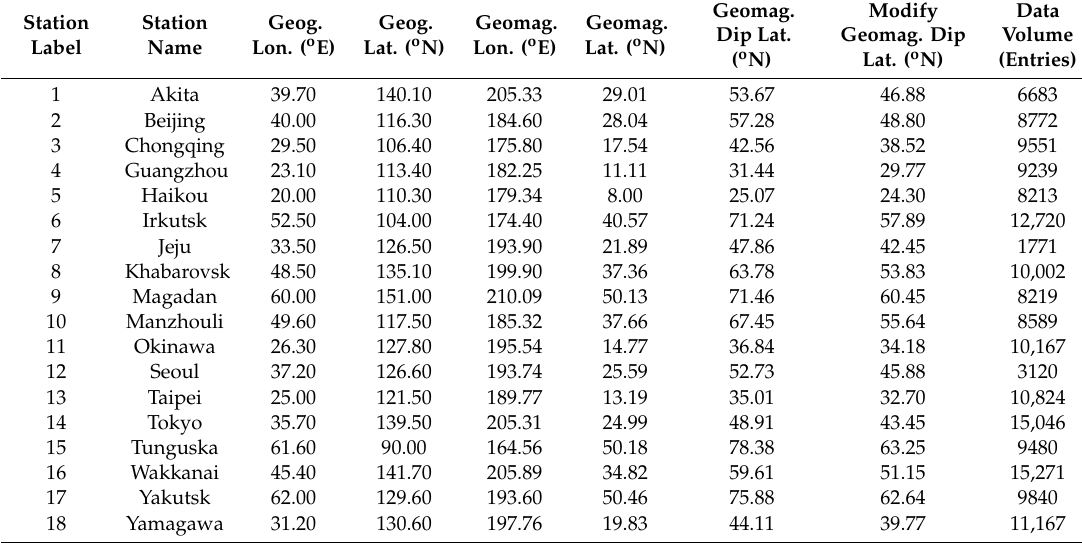
Table 1. Geographic and geomagnetic positions of the ionosonde stations used for model reconstruction and